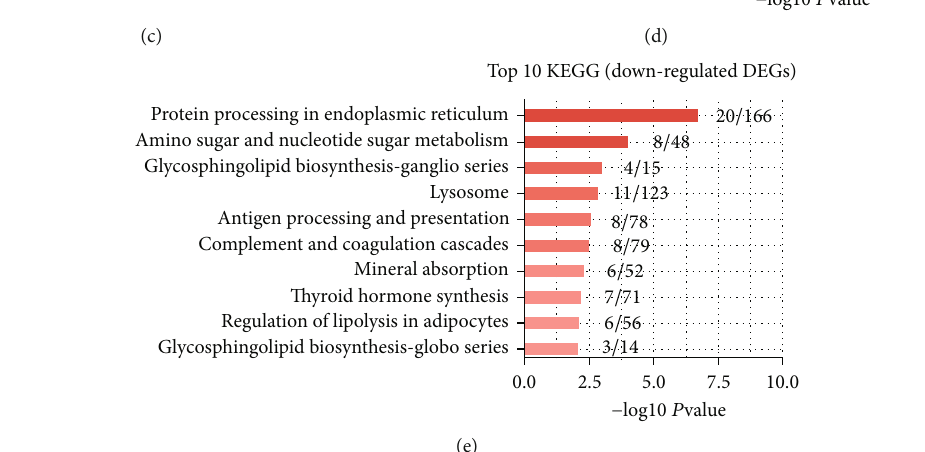
Figure 1: Transcriptome analysis of di ff erentially expressed genes (DEGs) in human retinal endothelial cells (HRECs) treated with hypoglycemia (LG) and hyperglycemia (HG). (a) Volcano gram showing all DEGs between LG and HG samples. Q value ≤ 0.05, FC ð foldchange Þ ≥ 2 or ≤ 0.5. (b) Principal component analysis (PCA) of LG and HG in HRECs based on FPKM value of all DEGs. The ellipse for each group is the con fi dence ellipse. (c) Heatmap for 3 LG and 3 HG samples, based on all DEG FPKM values. (d, e) The KEGG analysis of DEGs, dividing into up- and downregulated